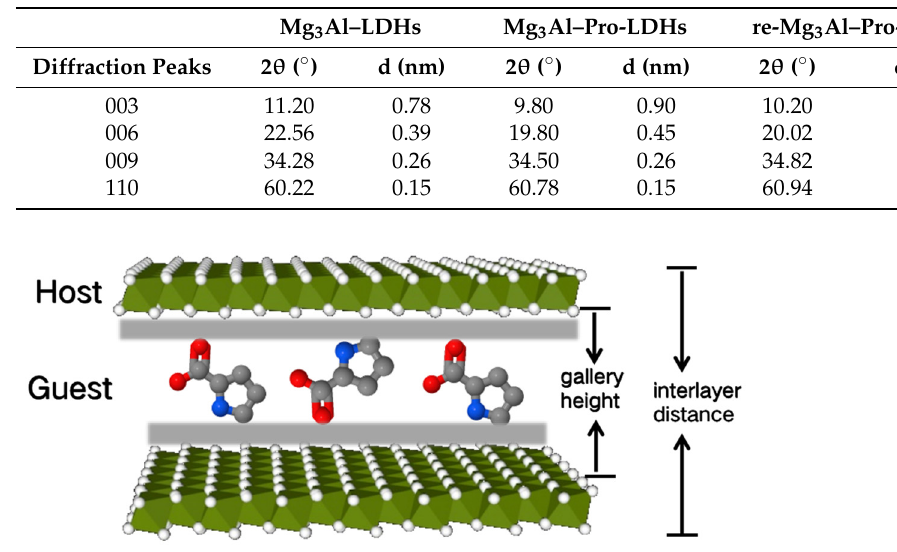
Figure 5. Structural model of L-proline-intercalated